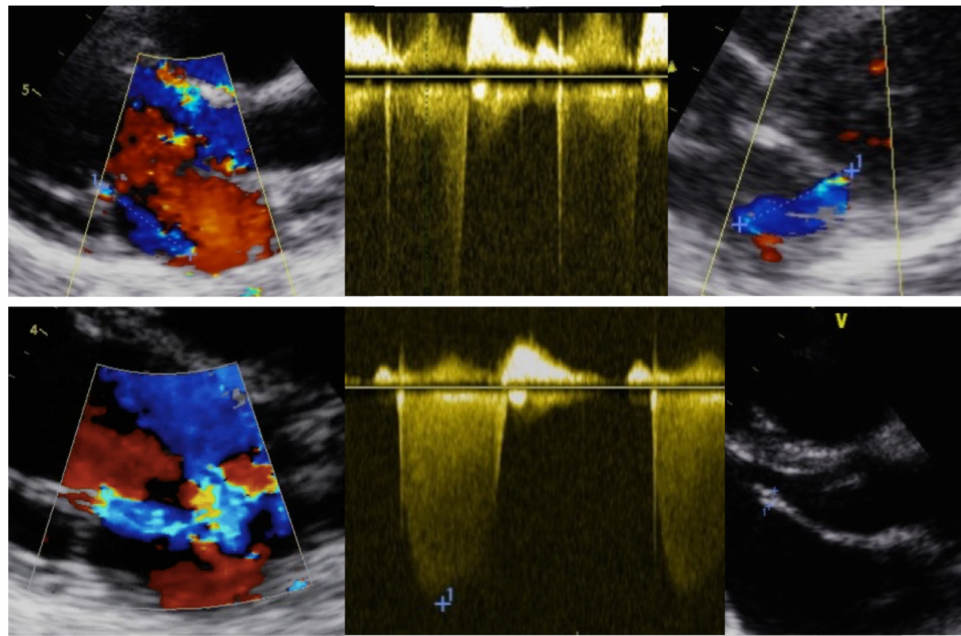
Figure 4. Echocardiographic images of RHD subjects. The top echocardiographic images show an example of a “borderline RHD” subject in which pathological MR is observed but without at least 2 morphological features of RHD. The bottom echo images show an example of a “definite RHD” individual; in this case, pathological MR plus 2 morphological features of RHD can be observed (MV anterior leaflet length > 3 mm and leaflet restrictive motion). Abbreviations: RHD: rheumatic heart disease; MR: mitral regurgitation; MV: mitral